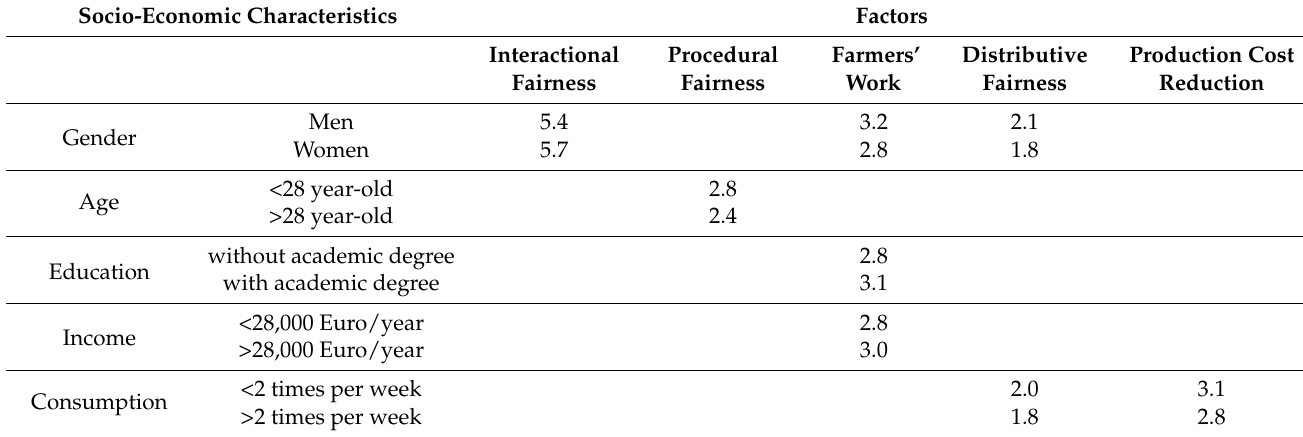
Table 8. Significant mean values of the socio-economic characteristics and consumption habits versus the factors of price